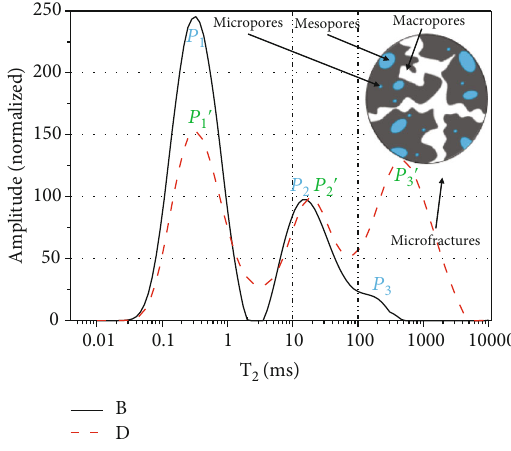
Figure 3: Results of nuclear magnetic resonance (NMR)